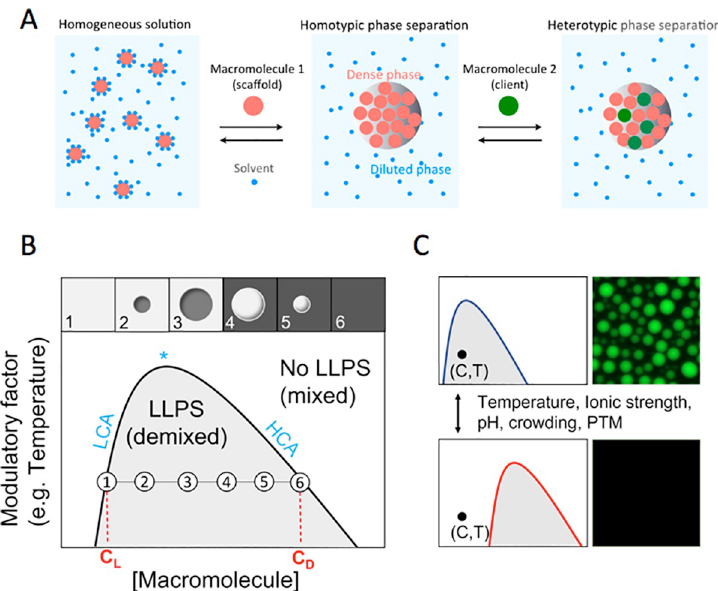
Fig 1. Overview of LLPS, phase diagram, and modulation. (A) Under certain conditions, a solvated macromolecule (scaffold) undergo homotypic LLPS and concentrate in a distinct liquid compartment (dense phase). One or more additional macromolecules (clients) can partition into the new phase through heterotypic LLPS. (B) A phase diagram describes the phase behavior of a binary (macromolecule and solvent) or multicomponent system (at least 2 macromolecules) as a function of macromolecular concentration or any other physicochemical factor that may modulate its condensation tendency. Here, we present a concentration vs temperature phase diagram for a binary system. A phase boundary (black curve, known as binodal) defines whether the system is in a 1-phase regime (mixed solution) or in a 2-phase regime (demixed solution). All coordinate pairs of concentration and temperature that lie beneath the phase boundary (gray) give rise to LLPS. The phase boundary maximum is the critical point (star), above which a homogeneous solution is seen at any macromolecular concentration. The critical point divides the phase boundary in 2 segments known as low concentration arm (LCA, left) and high concentration arm (HCA, right). The LCA defines the concentration of the diluted or light phase (CL), whereas the HCA defines the concentration of the dense phase (CD). Increasing total concentration in the light phase above the concentration threshold only changes the relative volumes between phases (i.e., droplets become larger at the expense of the diluted phase; see Fig 3). The top panel of (B) illustrates this phenomenon: (1) macromolecule concentration at threshold, no LLPS. At higher concentration, small droplets form (2) growing in size (3) as concentration increases. Eventually, the volume of the dense phase is higher than the diluted phase, so surface tension dictates the formation of diluted droplets surrounded by dense phase (4). After this inversion boundary, increasing concentration decreases the diluted droplets size (5) until a 1-phase regime of dense solution only is achieved (6). (C) Modulatory effectors such as PTMs or pH operate by altering the forces that drive droplet formation, thus changing the phase boundary. All of these modulatory effects may act in favor or against LLPS, depending on the nature of the interactions involved. For instance, addition of a negative charge by phosphorylation has the potential to engage components in electrostatic attractive or repulsive forces. C,T, concentration, temperature; HCA AU : AbbreviationlistshavebeencompiledforthoseusedinFigs 1 (cid:0) 3 : Pleaseverifythatallentriesarecorrect : , high concentration arm; LCA, low concentration arm; LLPS, liquid–liquid phase separation; PTM, posttranslational